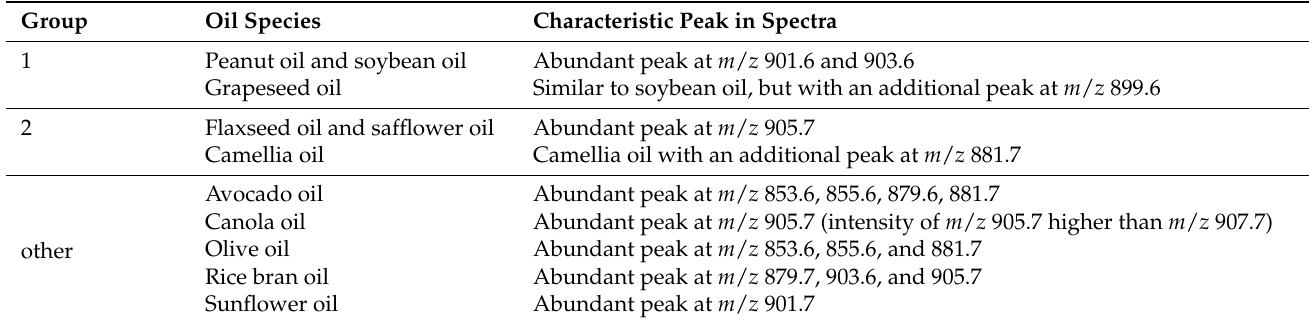
Table 1. Division of edible oils on the basis of their SALDI mass spectra and heatmap results.